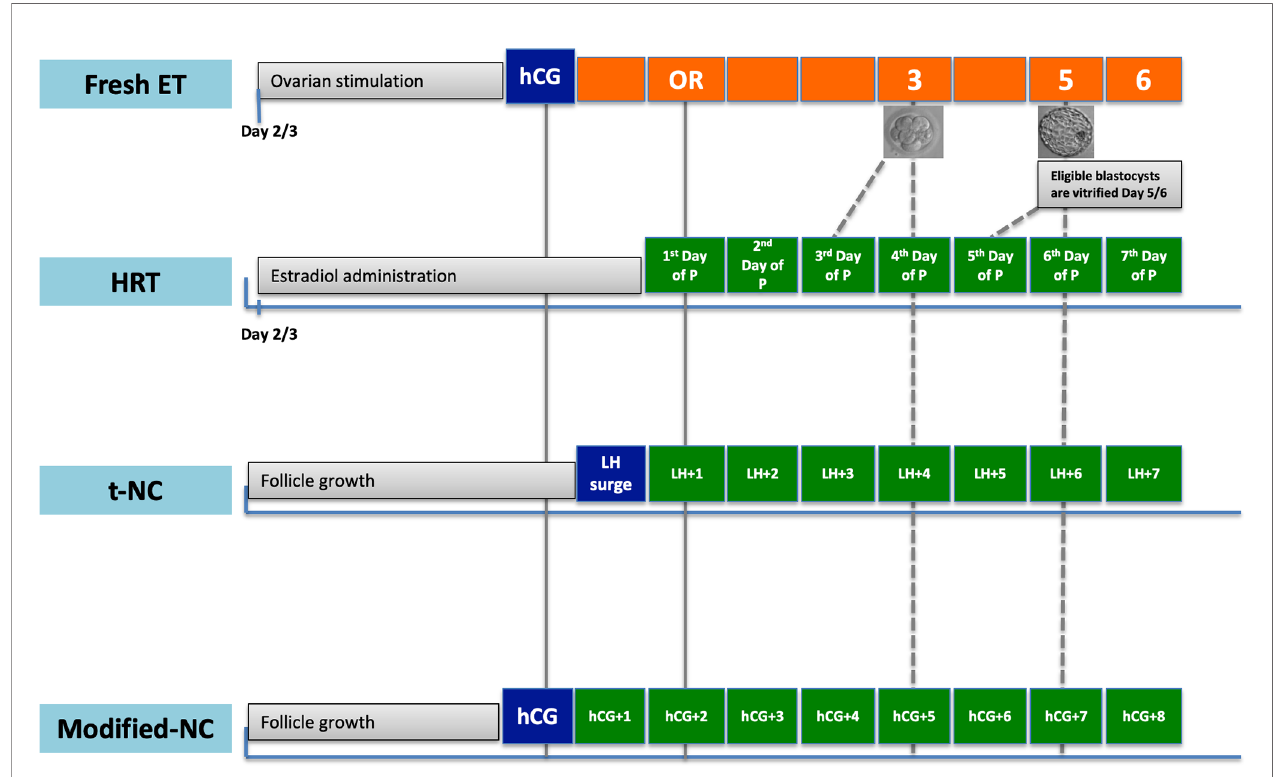
FIGURE 1 | Timing of warmed embryo transfer in hormone replacement treatment (HRT), true natural cycle (t-NC) and modi fi ed natural cycle (modi fi ed-NC) protocols to prime endometrium. hCG, human chorionic gonadotropin; ET, embryo transfer; P, progesterone; OR, oocyte retrieval; LH, luteinizing hormone. The dash-lines denote timing of warmed embryo transfer in different FET